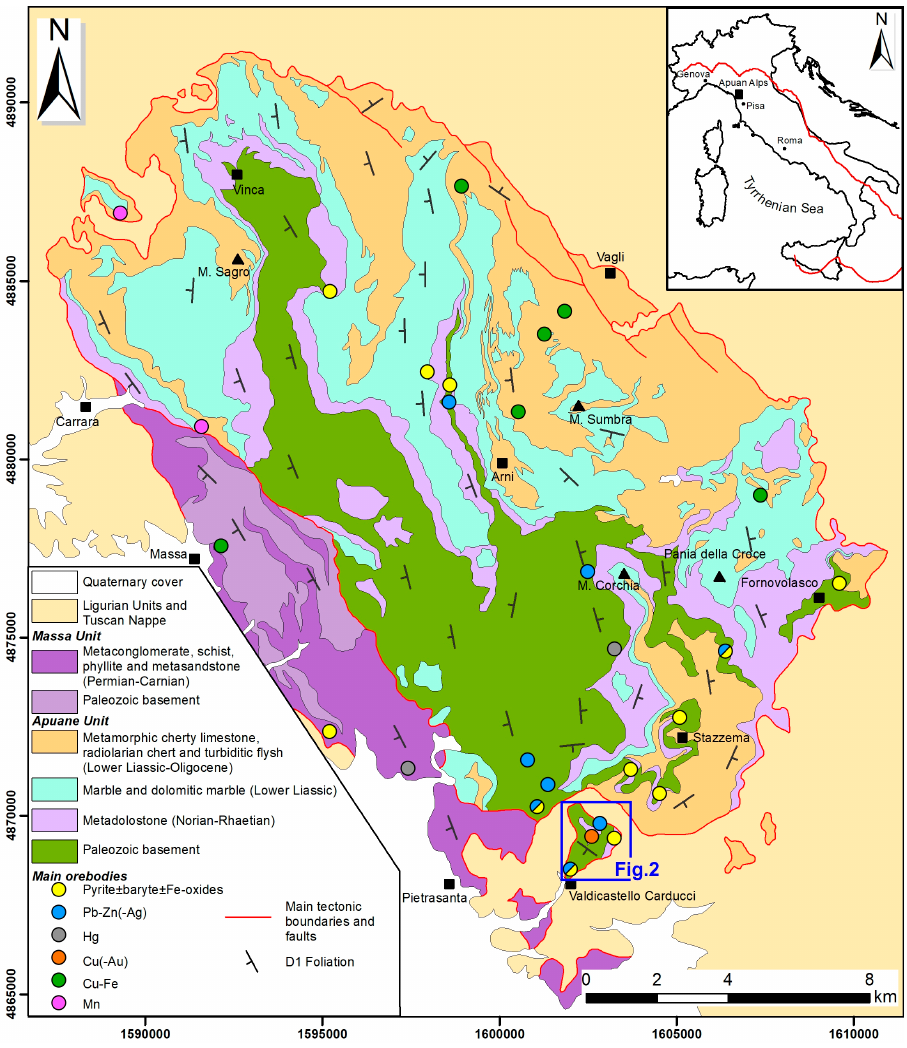
Figure 1. Geological sketch map (modified after Carmignani and Kligfield [11]) of the Alpi Apuane massif with location of the main orebodies (modified after Lattanzi et al. [14]).